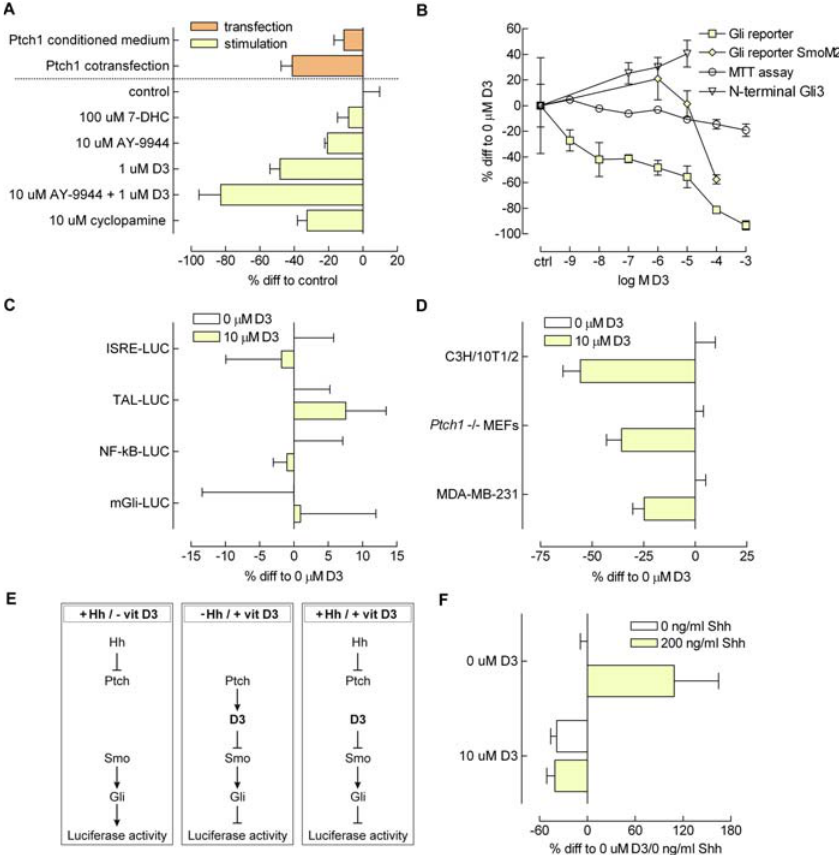
Figure 6. Analysis of Vitamin D3 as a Specific Smo